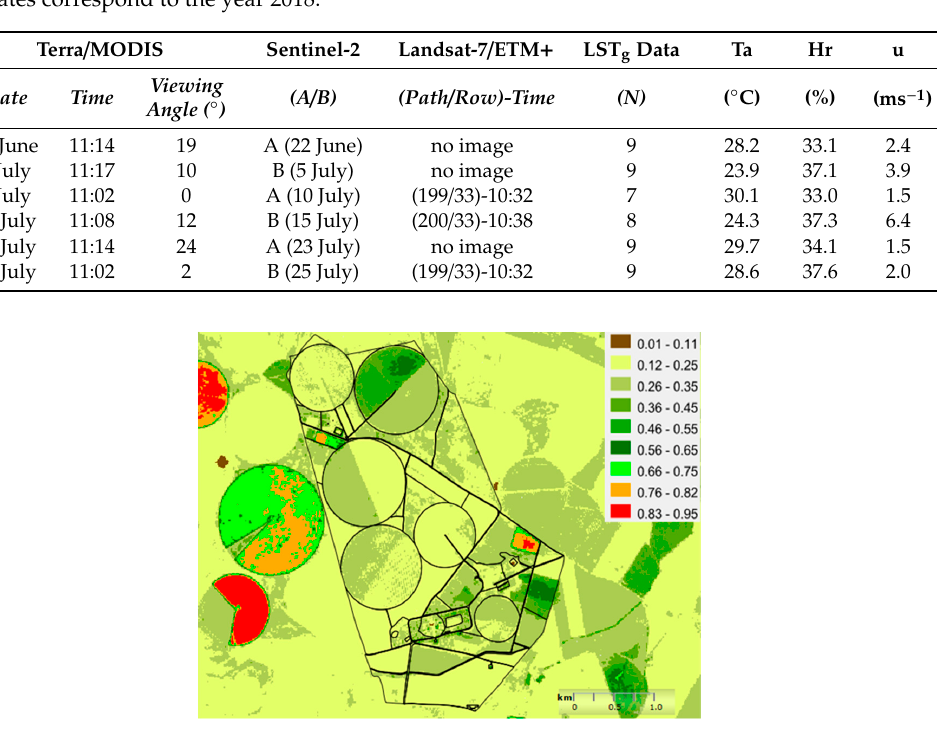
Figure 2. Sentinel-2 Normalized Difference Vegetation Index (NDVI) image of “Las Tiesas” farm, corresponding to date 25 July 2018.